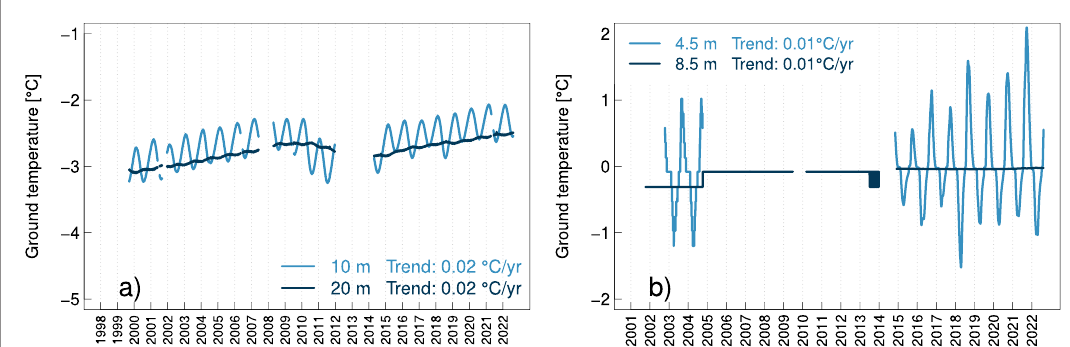
Figure A1. Long-term trends of ground temperature at Juvvasshøe (a) and Snøheim (b) for the monitoring period 1999–2022 and 2001–2022, respectively. For (a) long-term changes in permafrost thermal state at 10 and 20 m depth are shown while at (b) 4 and 8.5 m are presented. Time series for 2022 include data until 14 August